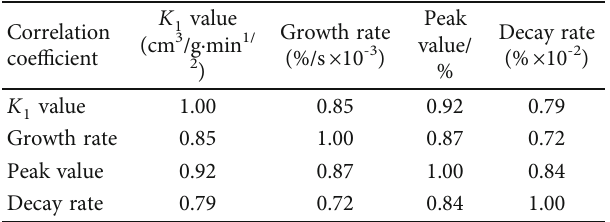
Figure 5: Variation characteristics of gas concentration after blasting under di ff erent K Table 2: Correlation between the growth rate, peak value, and decay rate of gas concentration and K 1 value.